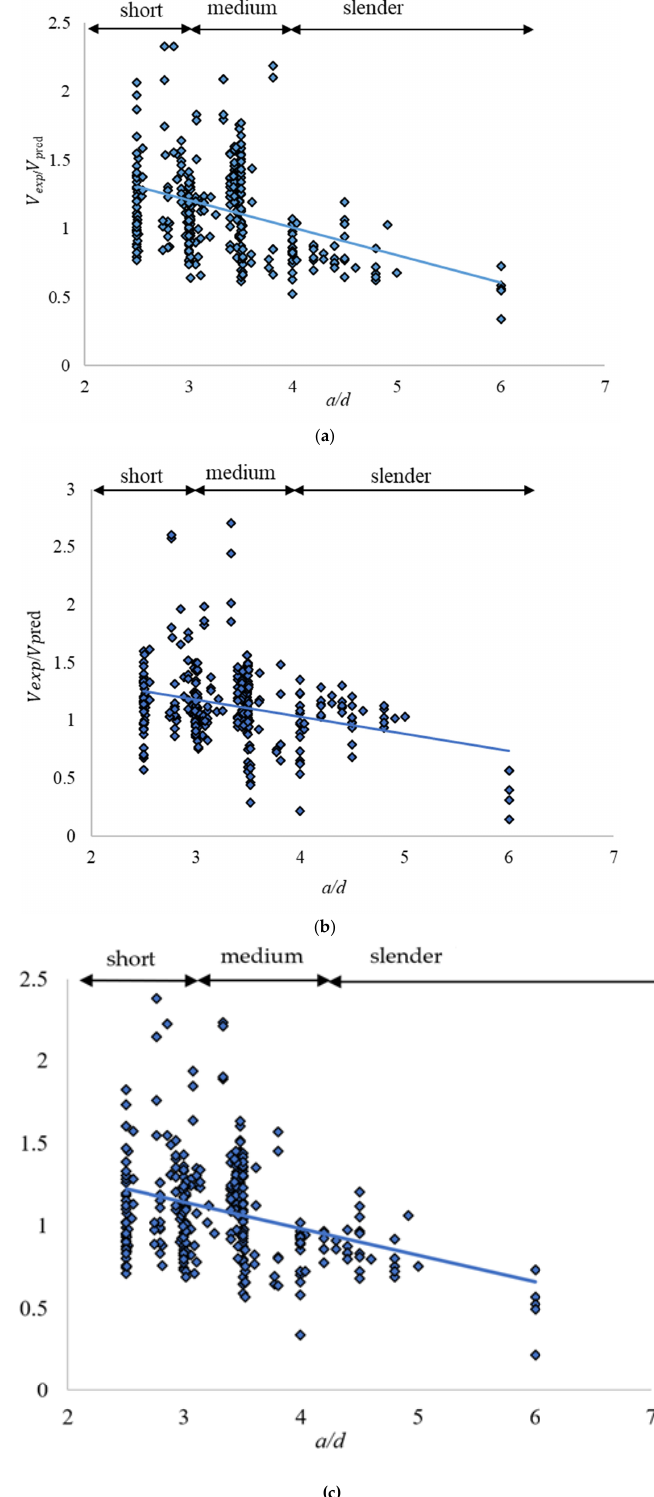
Figure 4. Variation of model uncertainty with shear span to e ff ective depth ratio a / d . ( a ) Plot for MC-10 model. ( b ) Plot for Bernat et al., model [27]. ( c ) Plot for DAfStB